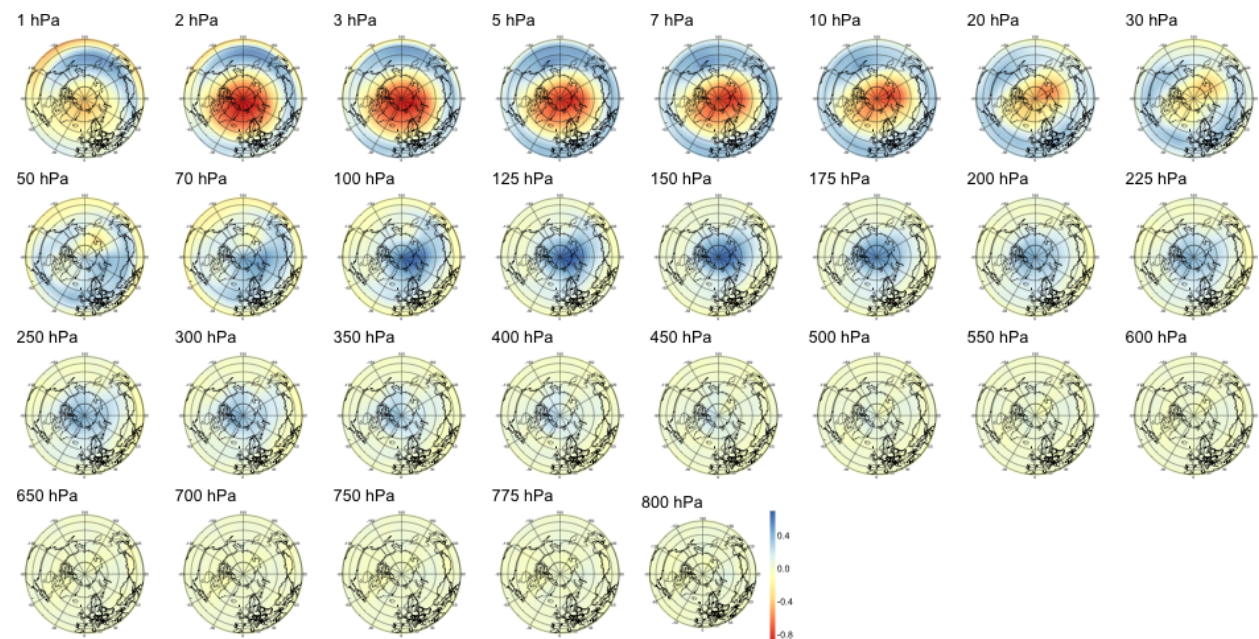
Figure B1. Pattern of PV anomalies maximizing correlation with the SSW index at a lead time of 6h.